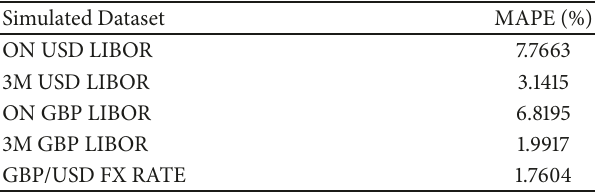
Table 8: Mean Error Test Results of the Simulated Models. Simulated Dataset MAPE (%)